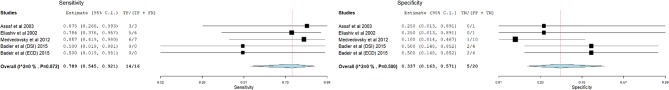
Forest plot showing sensitivity and specificity of the IC-MSI studies (individual studies: size of the squares are proportional to weights used in meta-analysis; the summary measure: center line of the diamond; associated 95% confidence intervals: lateral tips of the squares and the diamond).